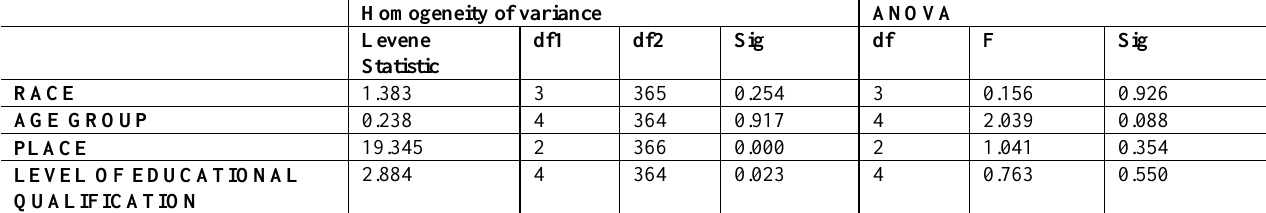
Table 6: Anova according to race, age group, place and level of educational qualification Homogeneity of variance